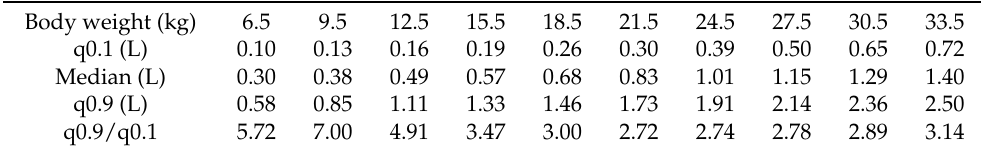
Table 1. Daily water intakes (in liters) according to weight. There is a factor of at least 2.7 (170%) between the volume of water drunk by the 10% heaviest drinkers and the 10% lightest drinkers. This factor reaches 7 (600%) at the beginning of the post-weaning